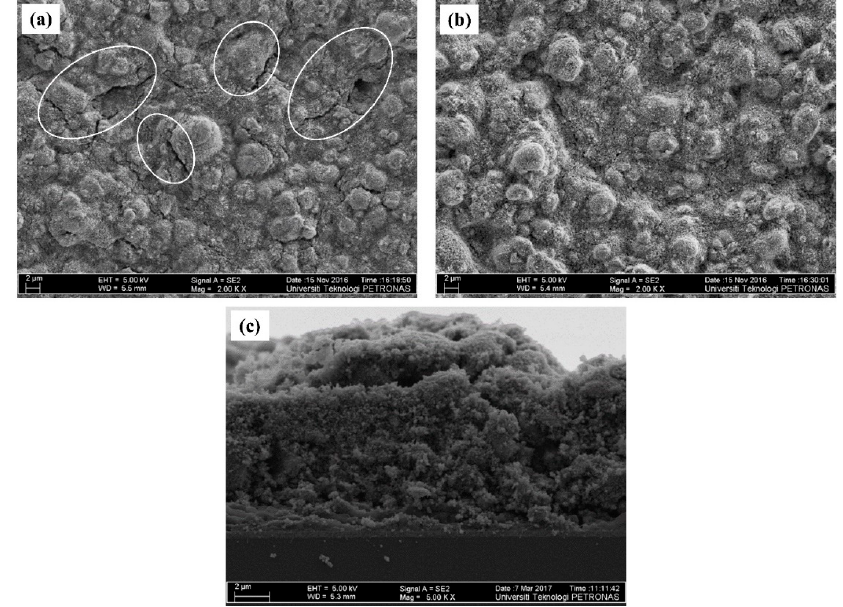
Figure 4. The FE-SEM images of the surface of the TiO 2 film ( a ) before and ( b ) after being coated with nanocrystalline TiO 2 , taken at 2000× magnification; ( c ) the cross-section image of the printed photoelectrode film.